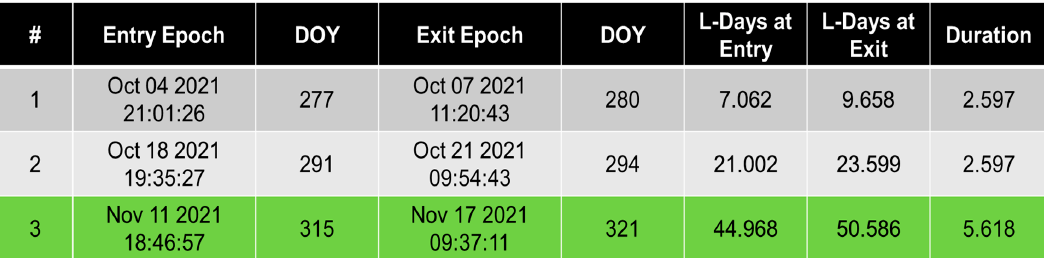
Figure 5. Under-fly epoch options with final selection highlighted in